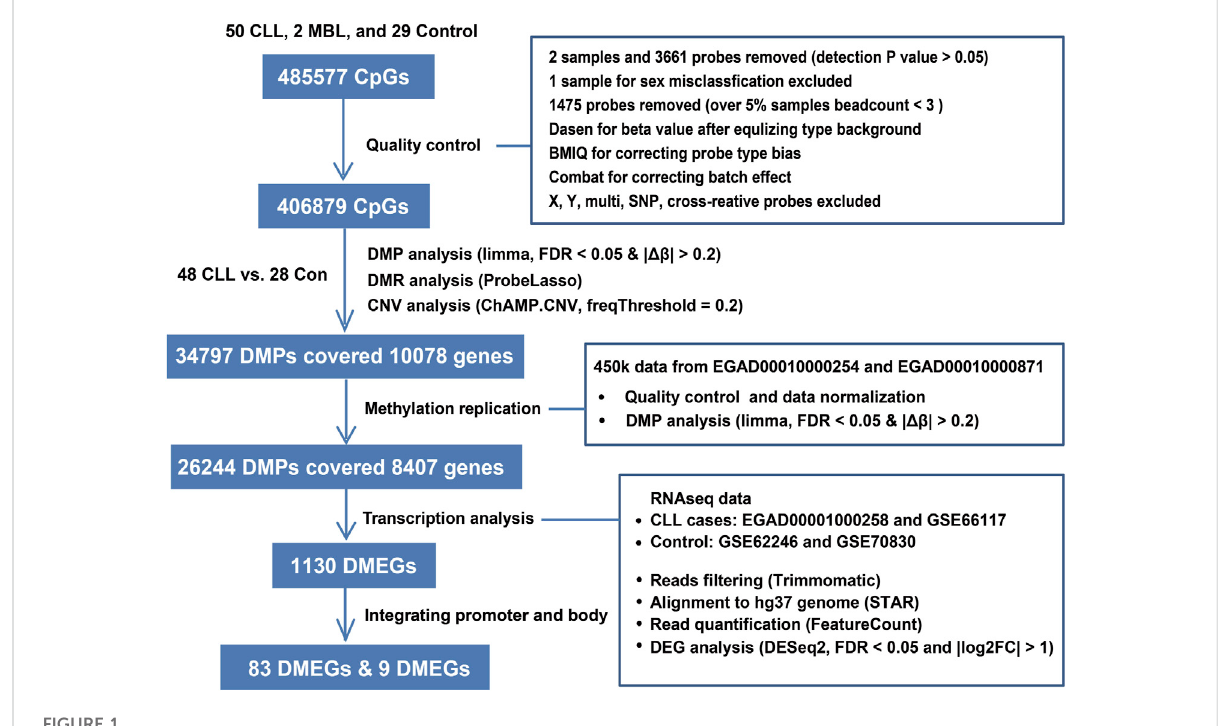
FIGURE 1 Flowchart showing our steps for identifying methylation